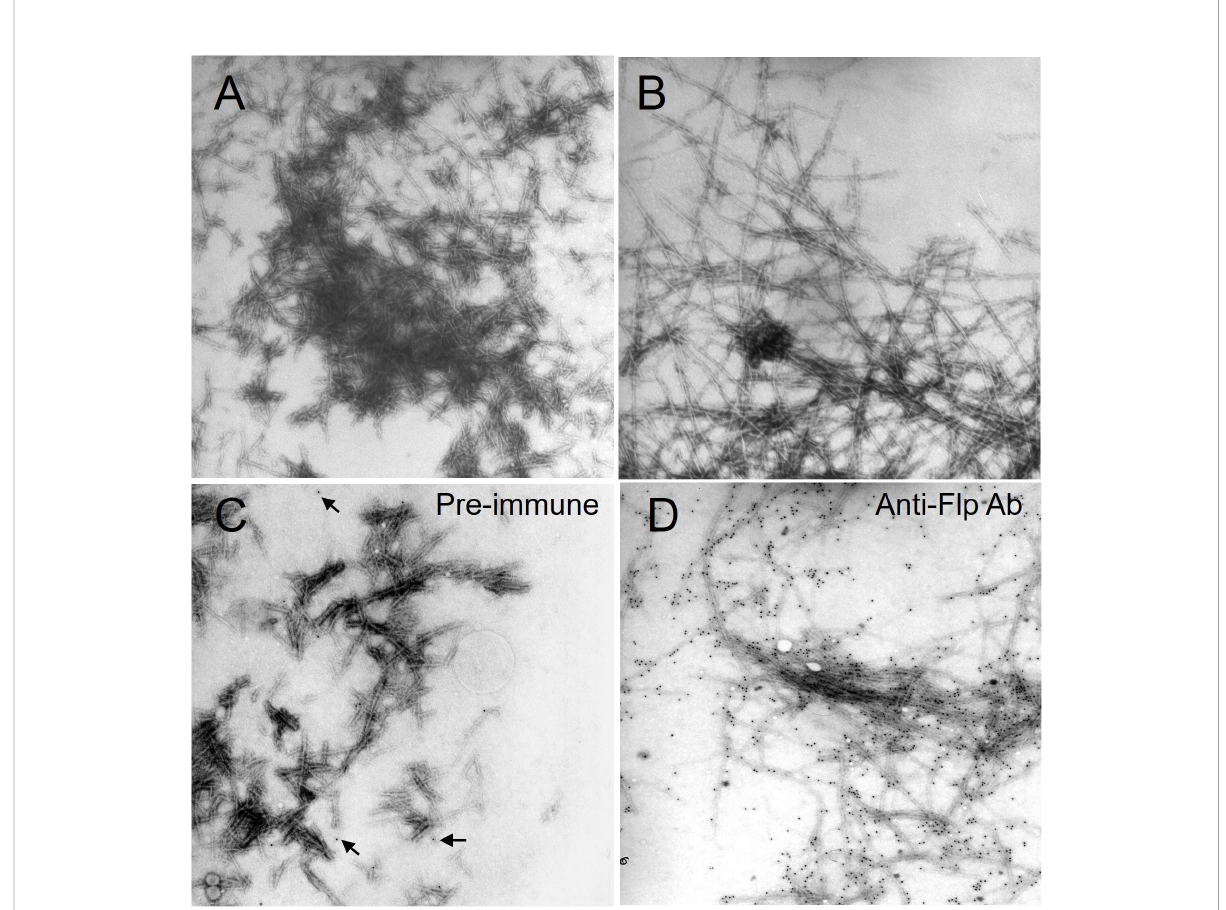
FIGURE 7 Flp peptide polymerizes in vitro . (A) At 2h post-incubation of puri fi ed Flp-peptide, densely staining aggregates showing short fi bers are detectable. (B) The fi bers appear longer and are more loosely associated after 18h incubation. Afterwards, the samples were recouped and passed through a cut-off fi lter. The substance retained by the fi lter was resuspended in PBS before immuno-electron microscopy experiments with either pre-immune (C) or anti-Flp peptide sera (D) . The localization of the 10 nm colloidal gold particles with the fi bers occurs only in the presence of anti-Flp peptide antisera. Original magni fi cations are